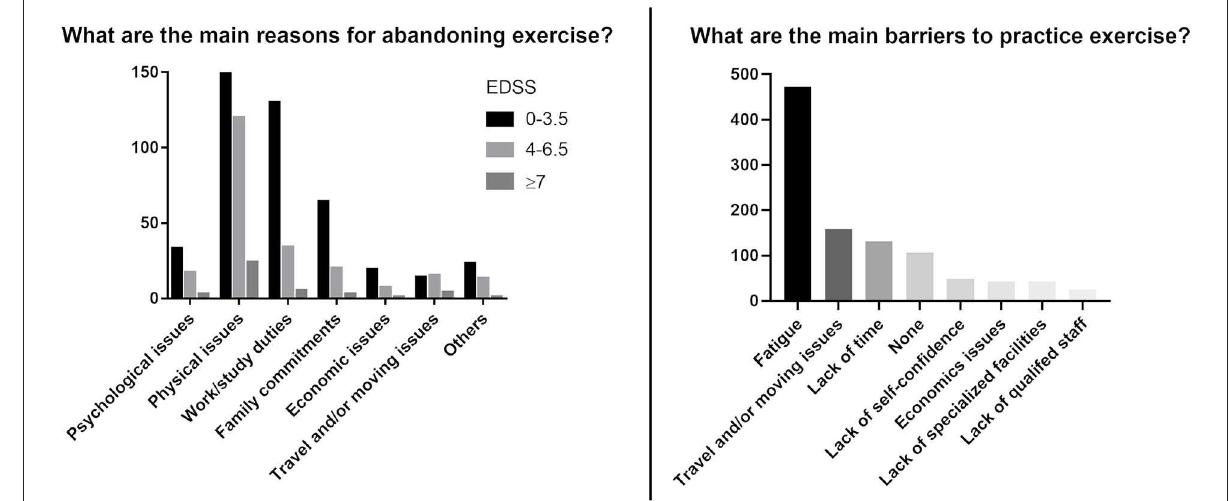
FIGURE1 Reasons for abandoning previous exercise activities and barriers to exercise (multiple responses were allowed).